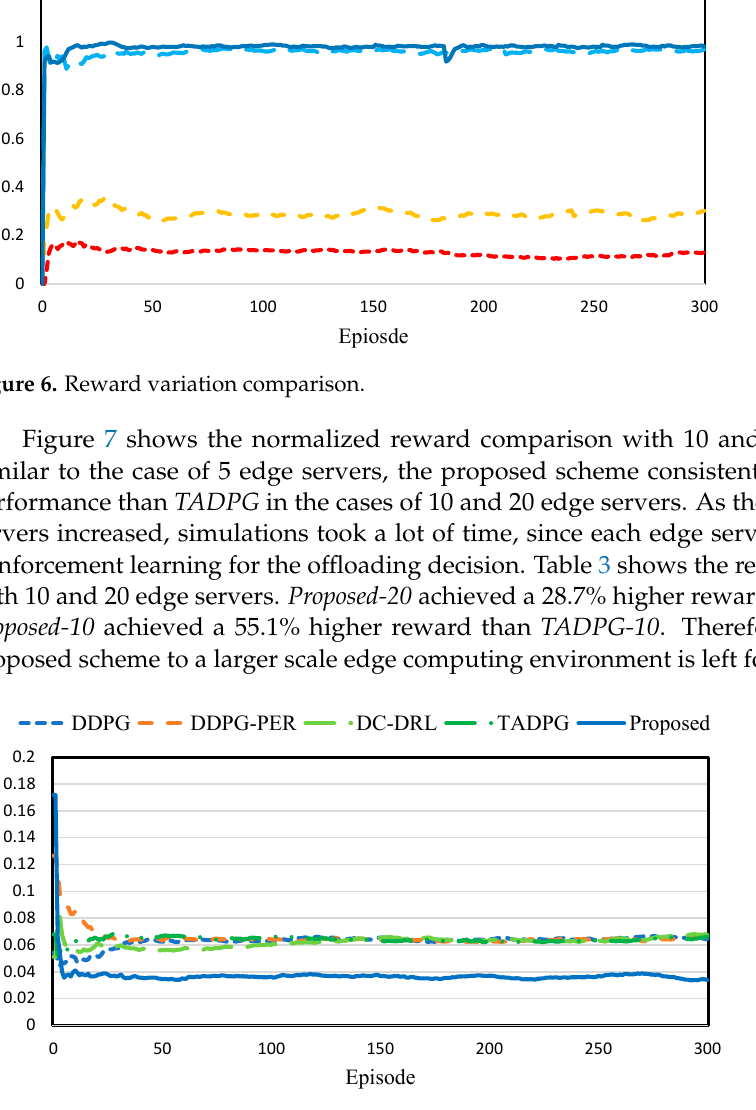
Table 3. Reward and variation